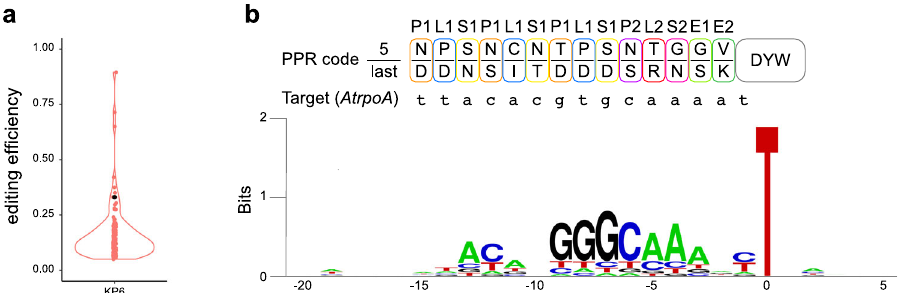
Fig. 6 Off-target effect of KP6 in HEK293T cells. a Violin plot shows the distribution of RNA editing ef fi ciencies at the on (black dot) and off-target (pink dots) editing sites. b Base preference of KP6 around the editing site. The sequence logo was generated by Weblogo